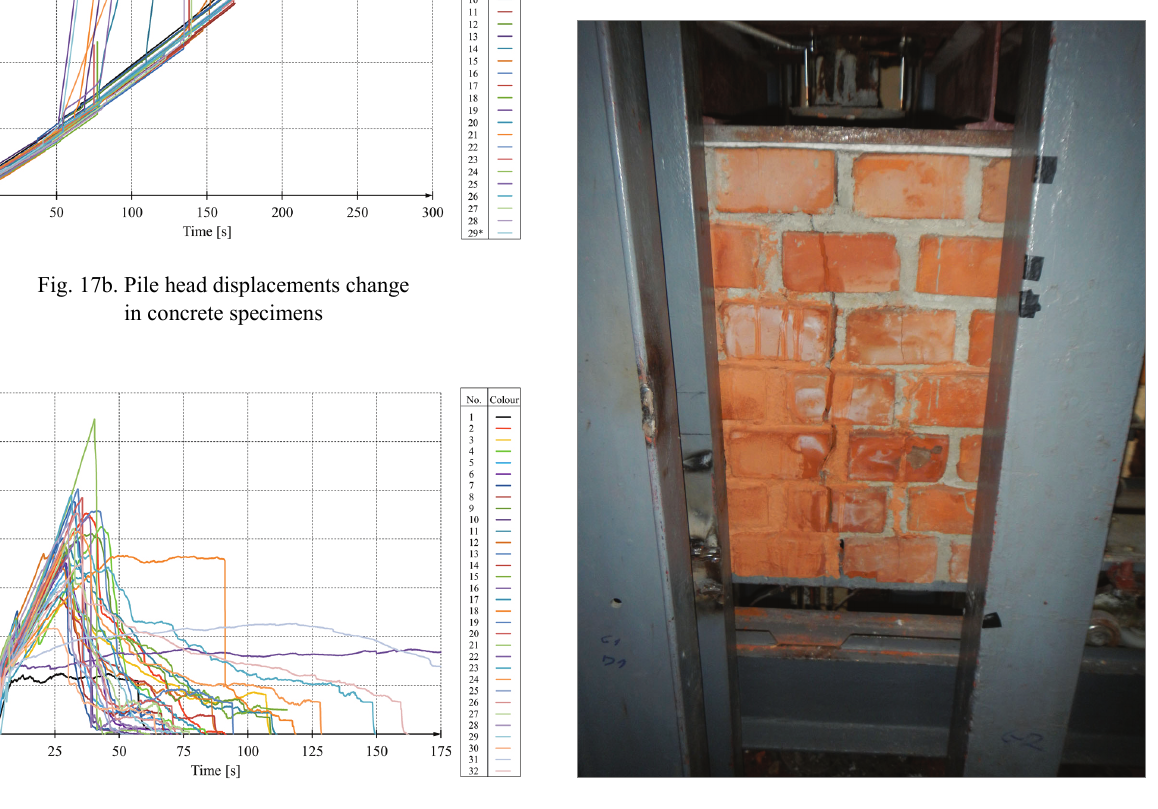
Fig. 18a. Force transferred by pile-masonry foundation anchorage over time